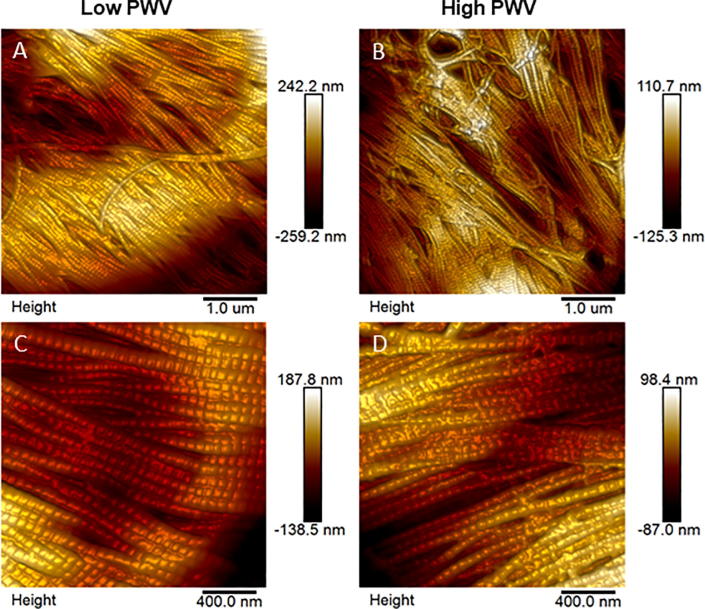
AFM topography images showing collagen fibrils in the adventitia. Example images are shown for the low (A) and high (B) PWV groups at 5 × 5 μm. Typical 2 × 2 μm images are also shown for the low (C) and high (D) PWV groups. At this scan size, individual collagen fibrils were clearly visible with their characteristic D-Period.